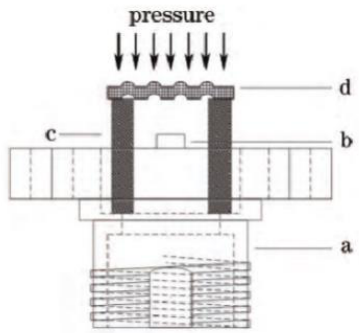
Figure 7. Schematic of the fiber-optic Fabry-Perot sensor based on stainless steel CD. (a: fiber flange; b: ceramic ferrule; c: glass ring; d: CD) (Reproduced from [19] ).